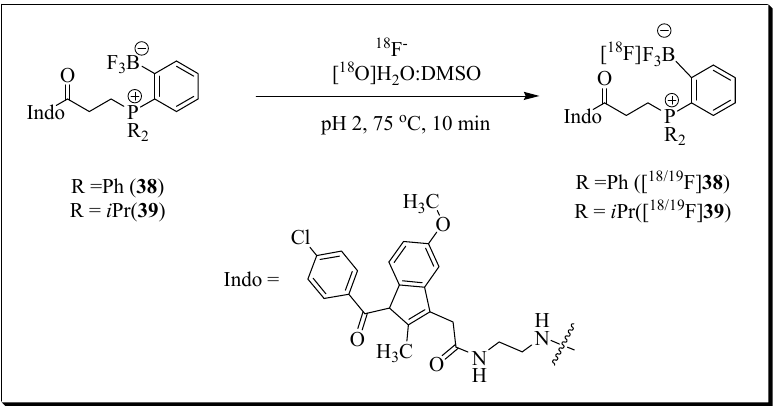
Figure 12. Scheme showing the radiolabeling of 38 and 39 by isotopic exchange in an aqueous solution. 7.